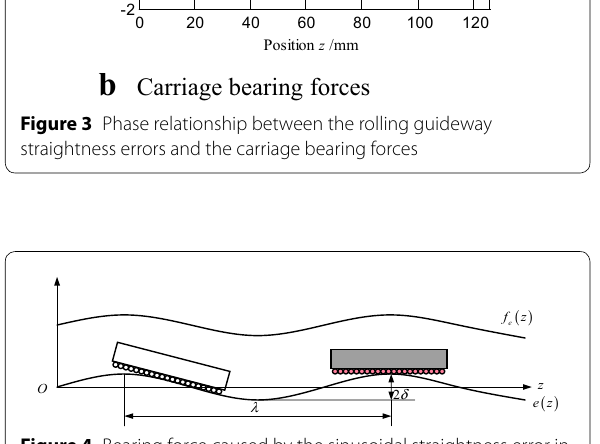
Eq. (11) describes the averaging effect of the rollers on the raceway errors at different frequencies.